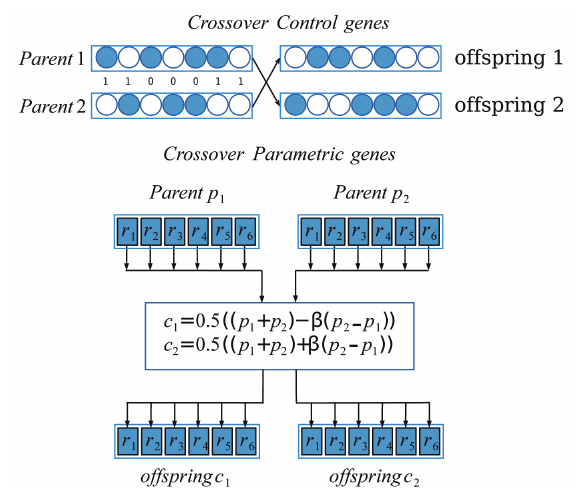
Figure 2. Crossover operator. For control genes, the ones indicate which genes are interchanged according with a uniform probability.